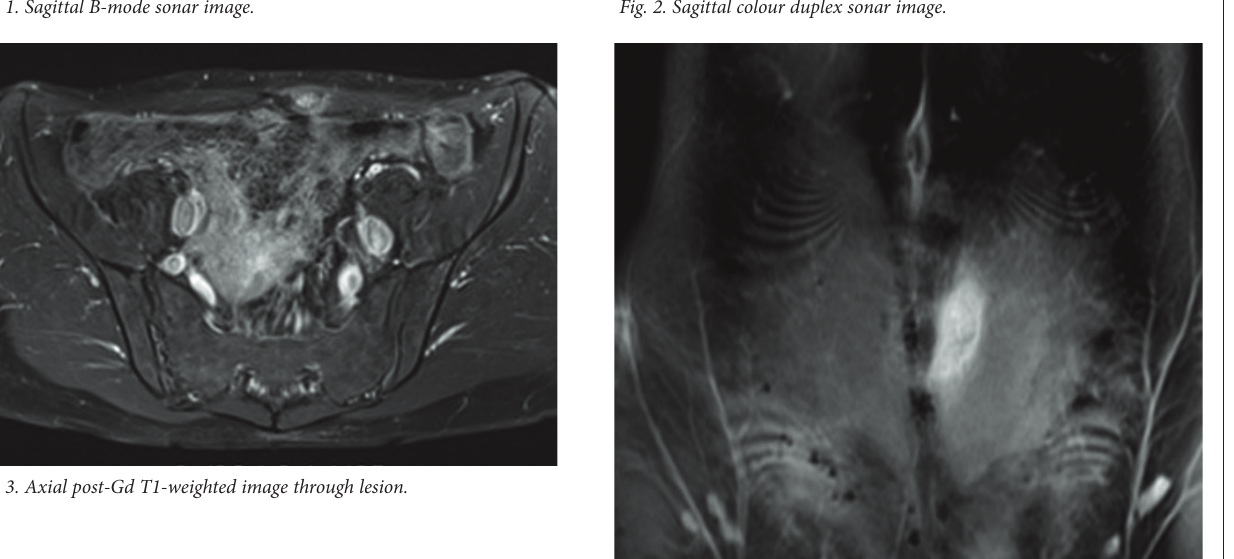
Fig. 2. Sagittal colour duplex sonar image.